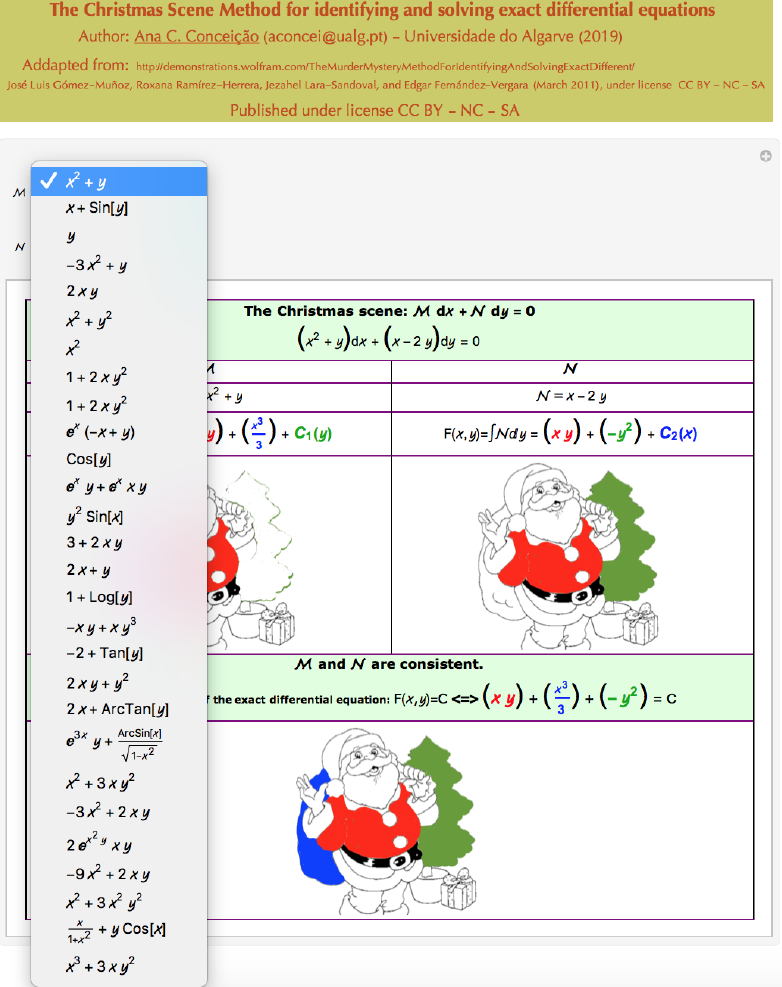
Figure 8. Some of the possible functions for the function M when using the tool Christmas Scene Method for identifying and solving exact differential